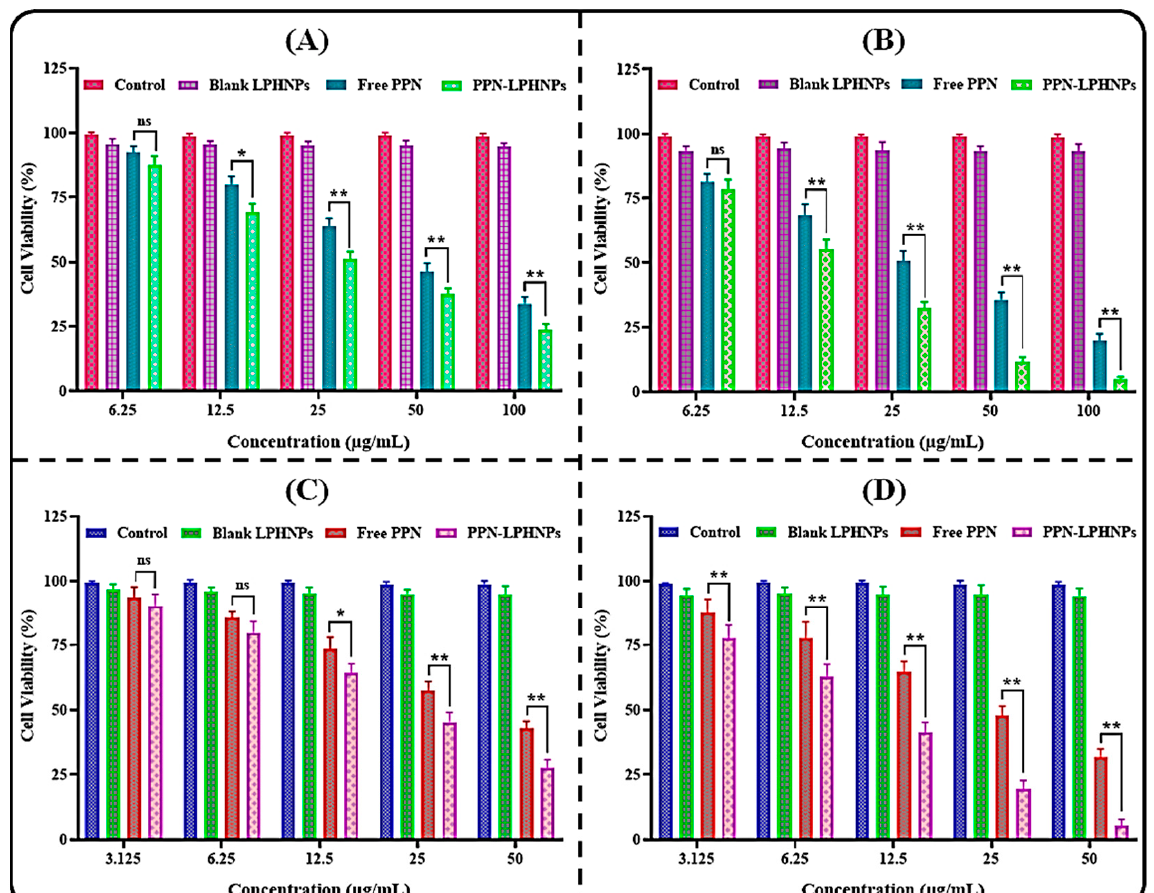
Figure 8. Image representing cytotoxicity assay of free PPN and PPN-LPHNPs against ( A ) MDA- MB-231 cells after 48 h, ( B ) MDA-MB-231 cells after 72 h, ( C ) MCF-7 cells after 48 h, and ( D ) MCF-7 cells after 72 h. Results are represented as a percent mean ± SD (n = 3). ns, * and ** represent non-significant, significant and highly significant differences between the two groups.